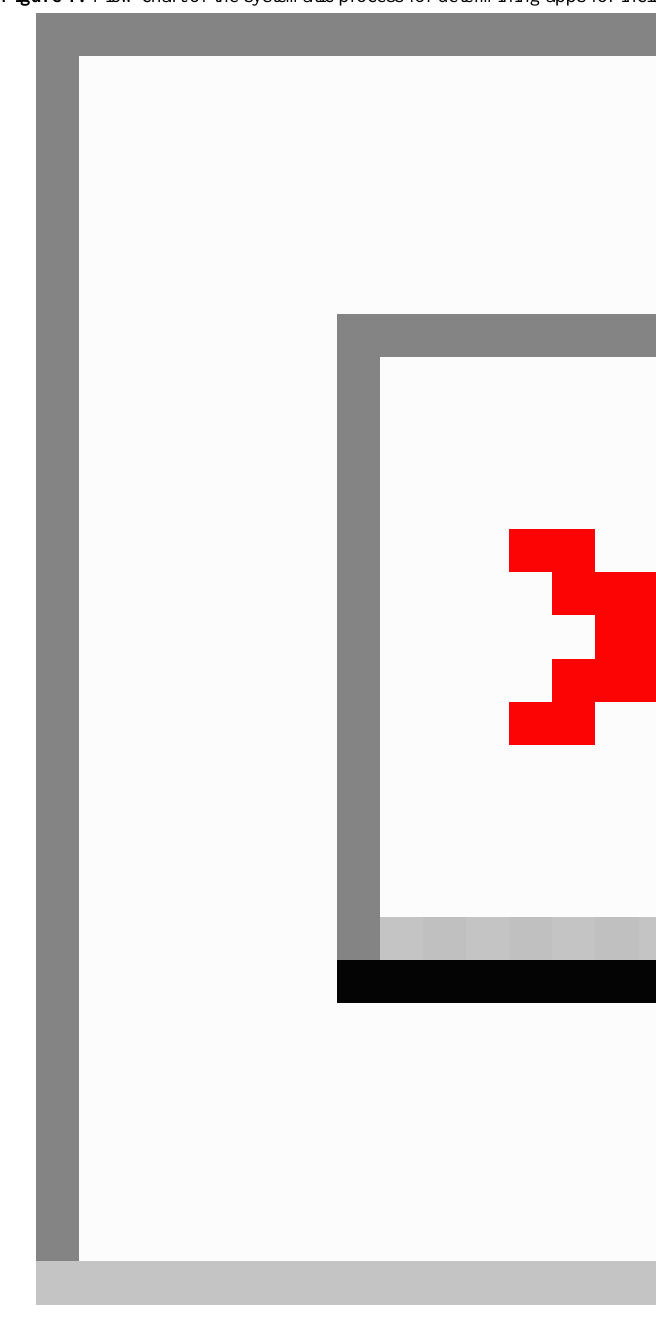
Figure 1. Flow chart of the systematic process for determining apps for inclusion in the final